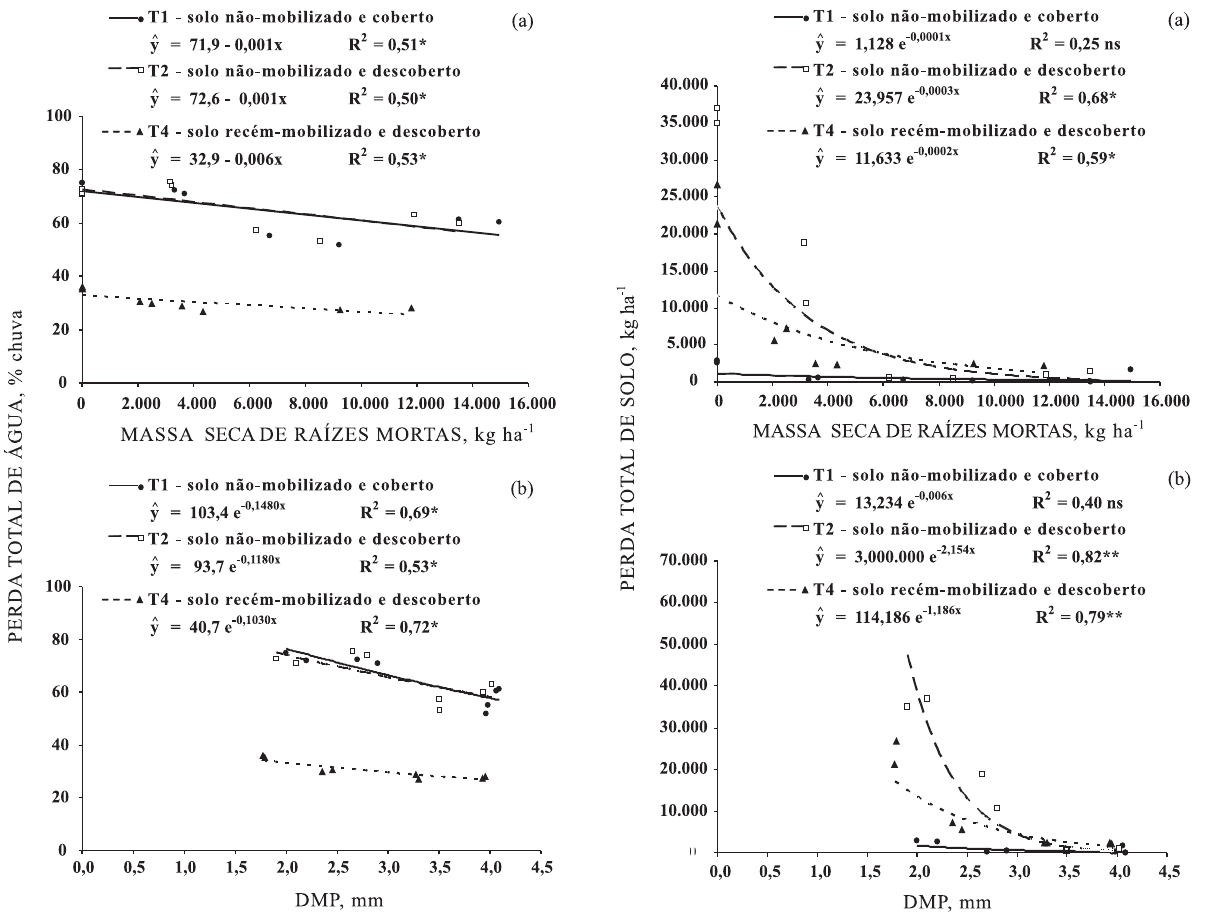
Figura 4. Relação da perda total de água com a massa de raízes mortas secas (a) e com o diâmetro médio ponderado – DMP - de agregados (b) na camada de 0 a 10 cm, em distintas condições físicas da camada superficial do solo, independentemente das seqüências culturais estudadas.